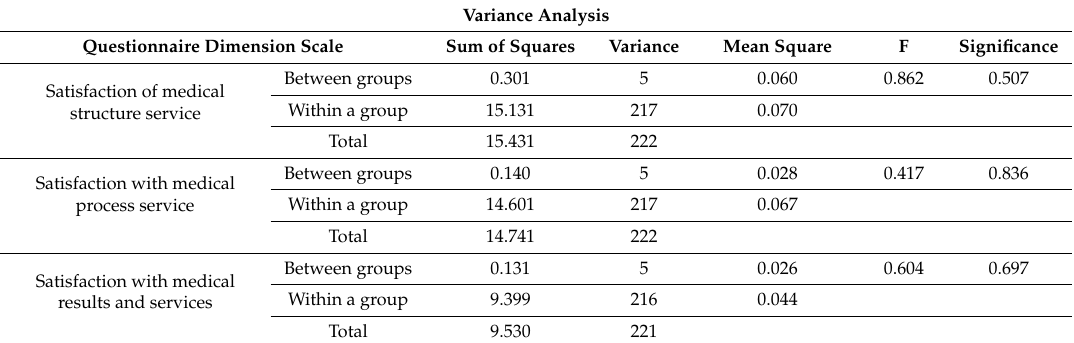
Table 23. Analysis of educational level and scale dimension variables.